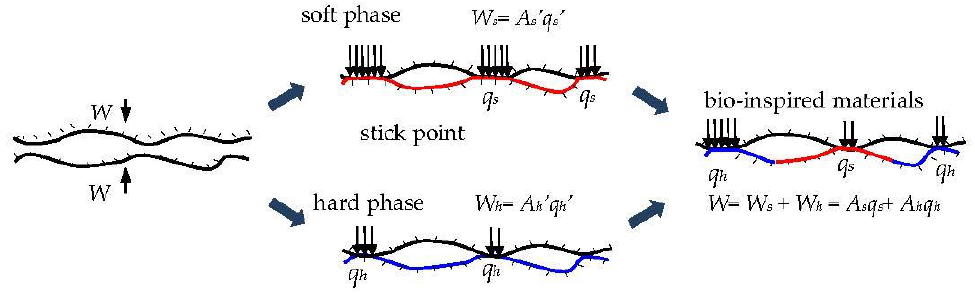
Figure 1. Schematic illustration for the rubbing interface of bio-inspired hard-soft-integrated materials (BHSIMs).